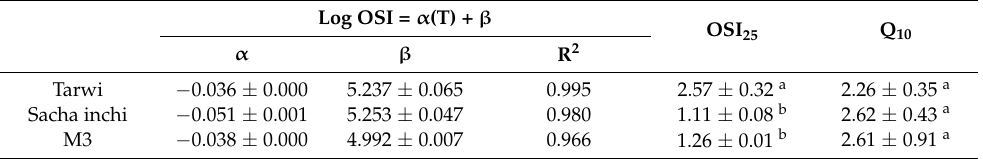
Table 4. Mean ( ± SD) shelf life (oxidative stability index at 25 ◦ C in years; OSI25) and Q10 (increase in reaction rate due to a 10 ◦ C temperature rise) of tarwi oil, sacha inchi oil and their 1:1 blend (M3). Log OSI = α (T) +